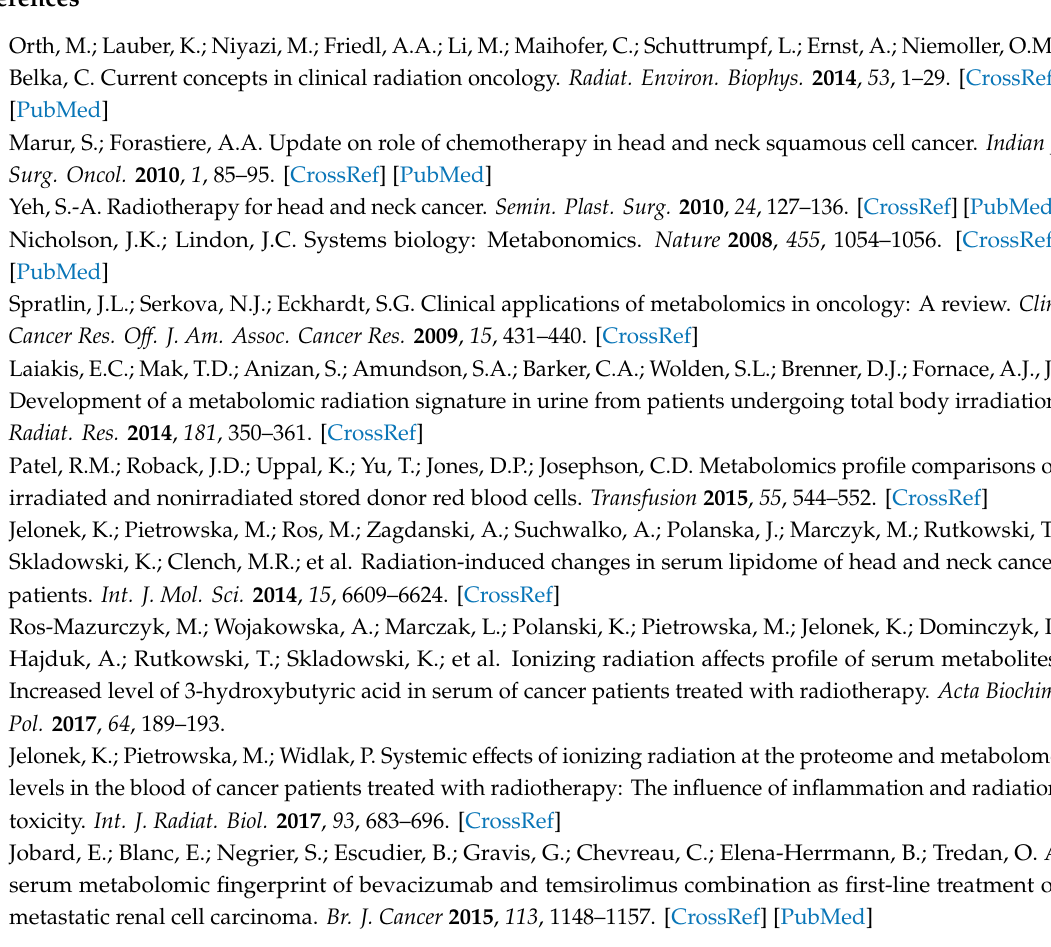
Table S1: Complete list of lipids present in lipid isomer groups that showed di ff erences between groups of patients; Table S2: Treatment-induced changes in levels of selected amino acids and their derivatives analyzed by LC /